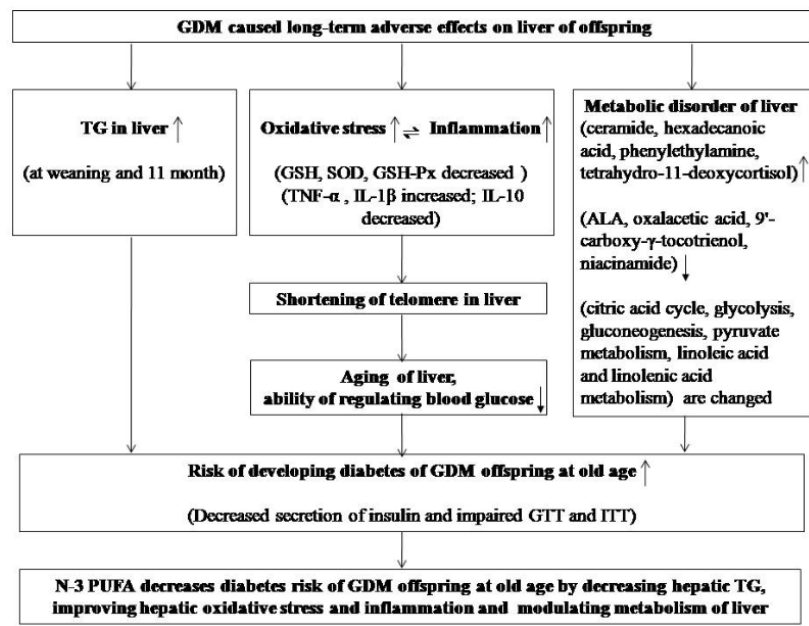
Figure 6. A summary figure showing all of the